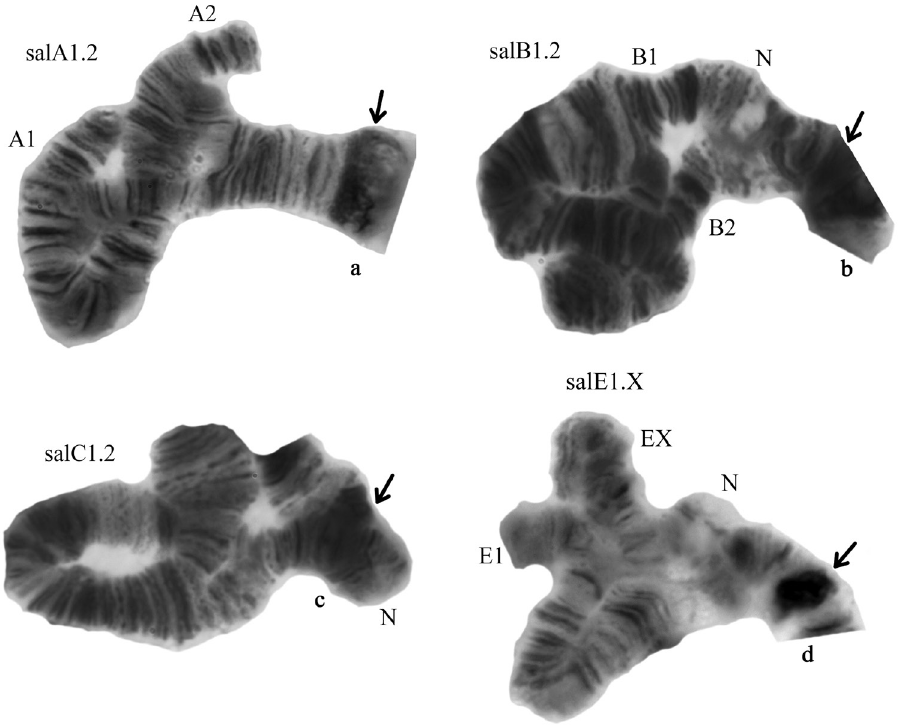
Figure 4. Chromosome inversions in different arms of G. salinus from Tambukan Lake. Heterozygous zygotic combination key: a salA1.2 b salB1.2 c salC1.2 d salE1.X. Designations as in Fig. 2.